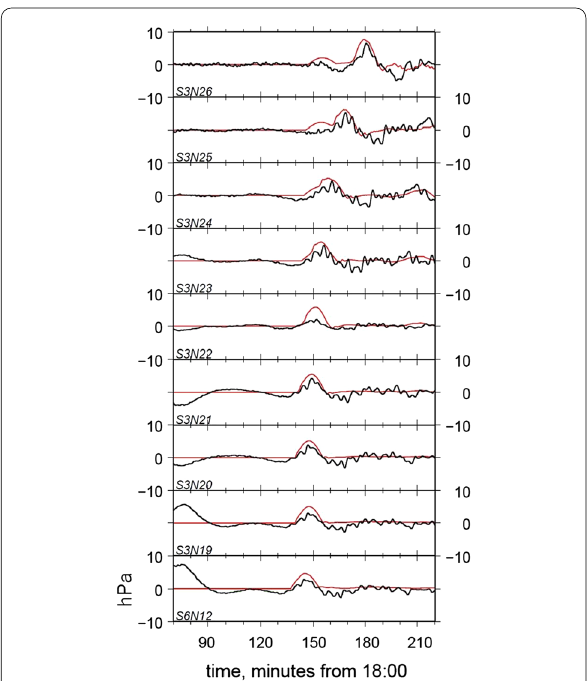
Fig. 4 Comparison of observed and computed waveforms at the nine sensors shown in Fig. 2. Black represents observed waveforms, and red represents computed waveforms. Long-period waves in the first 100 min in the observed waveforms are an effect of the bandpass